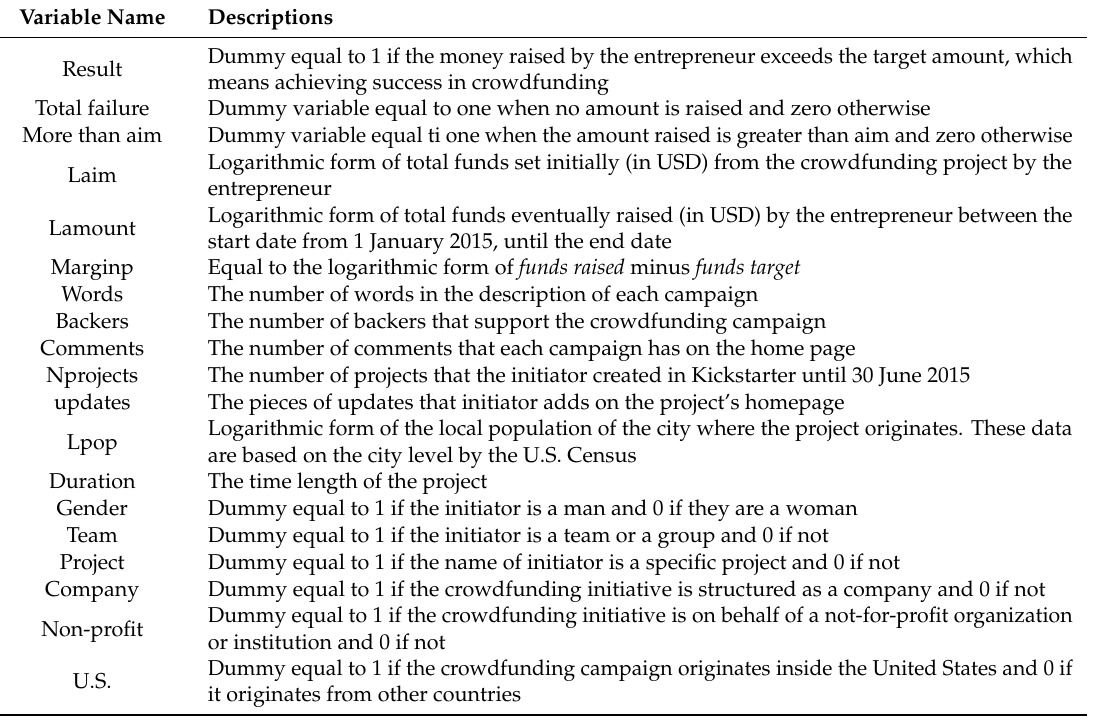
Table 3. Descriptions of variables. This table provides descriptions of the di ff erent variables used in this study.